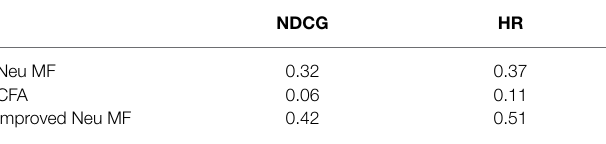
TABLE 2 | NDCG and HR experimental results.